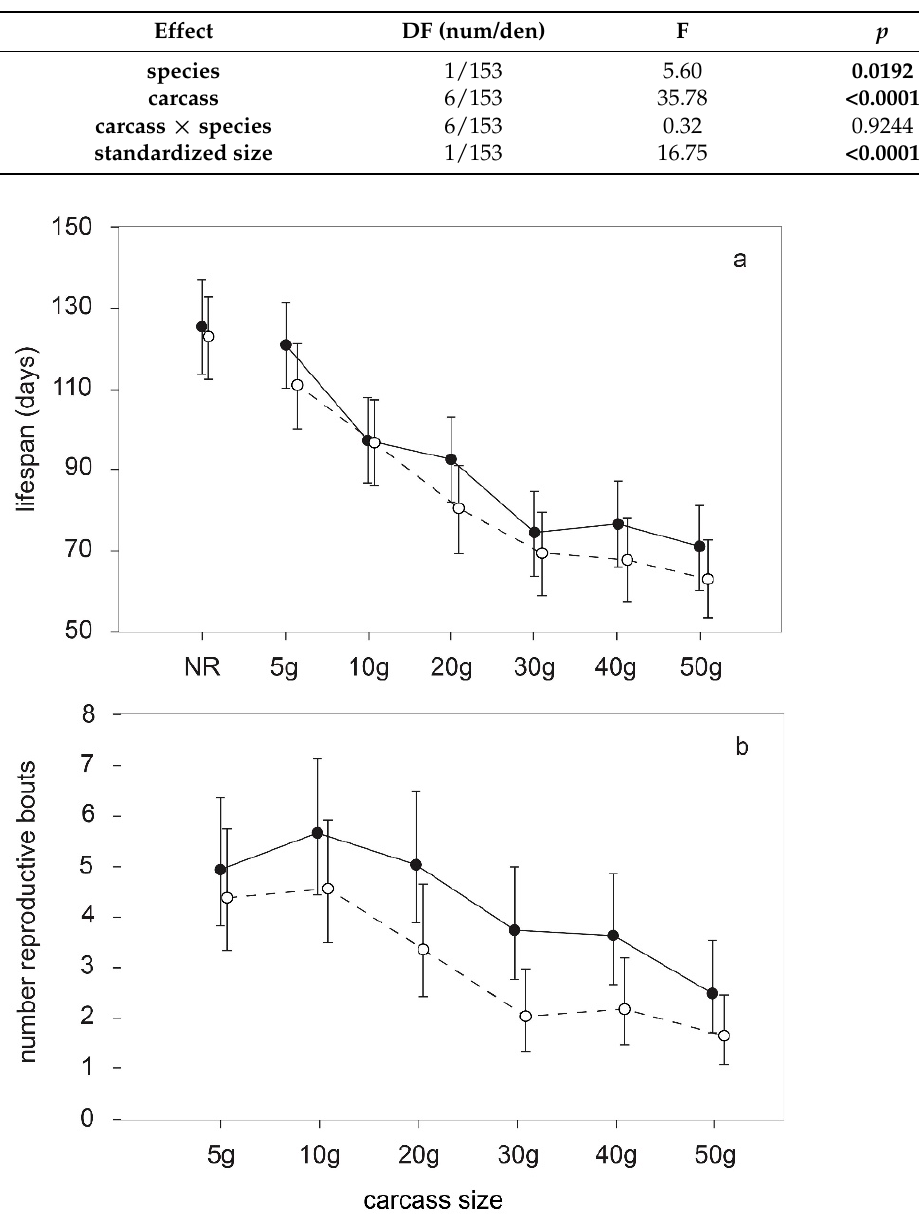
Figure 2. ( a ) Mean lifespan (in days; error bars are 95% confidence interval) of N. marginatus (solid circle and line) and N. guttula (open circles and dashed line) across six carcass sizes. NR indicates nonreproductive treatment. ( b ) Mean number of reproductive bouts (error bars are 95% confidence interval) for N. marginatus (solid circle and line) and N. guttula (open circles and dashed line) across six carcass sizes.